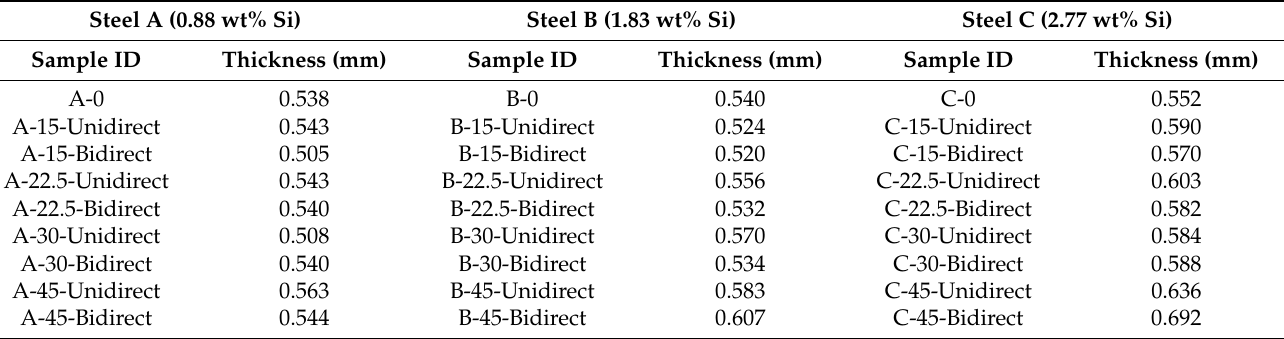
Figure 1. Schematic illustration of the skew cold rolling process [26]: ( a ) sample cutting from hot rolled plate, ( b ) the skew rolling process and ( c ) the two feeding patterns. HRD: hot rolling direction; HTD: hot transverse direction. Table 2. Sheet thicknesses after skew cold